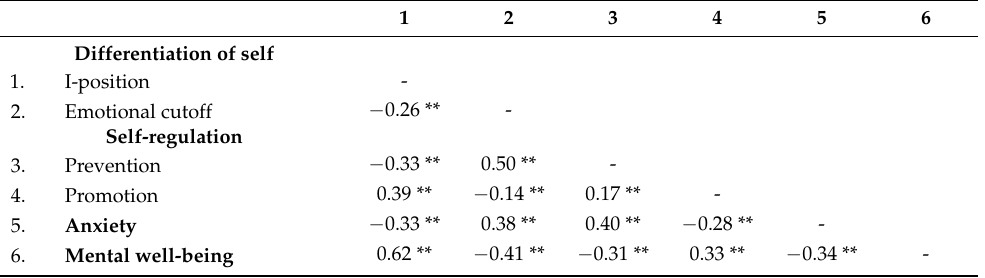
Table 2. Pearson Correlations between Study Variables (N = 460).